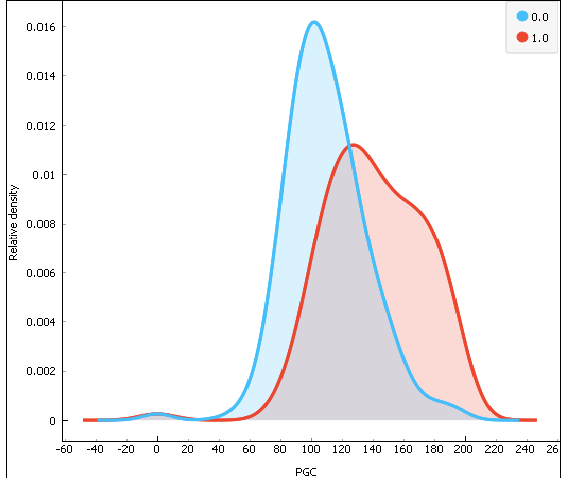
Figure 10. The distribution of the plasma glucose concentration (PGC) for the two classes (0-diabetes and 1-non-diabetes).